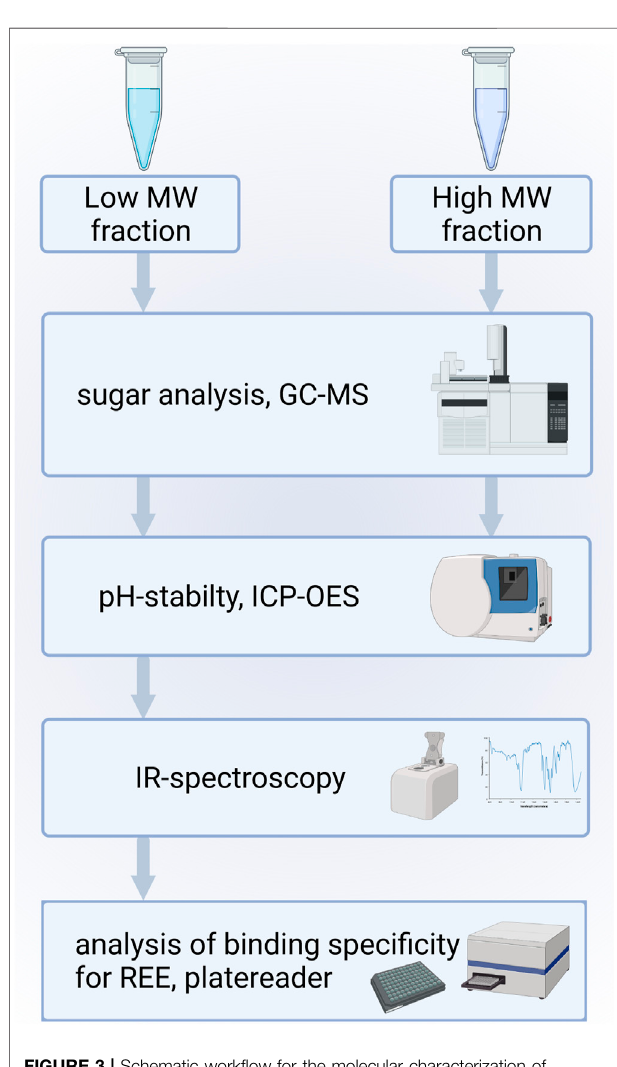
FIGURE 3 | Schematic work fl ow for the molecular characterization of isolated metal